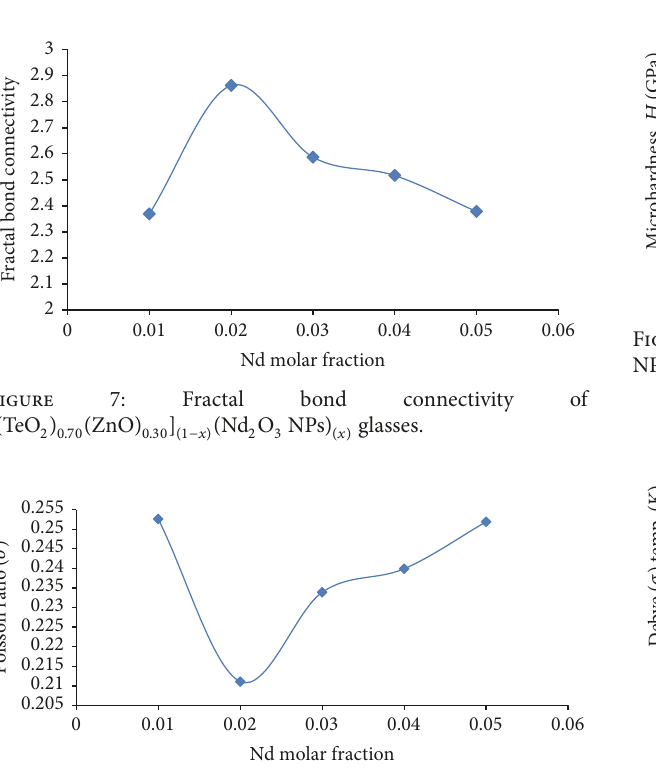
Figure 8: Poisson’s ratio of [(TeO 2 ) 0.70 (ZnO) 0.30 ] (1−𝑥) (Nd 2 O 3 NPs) (𝑥) glasses.